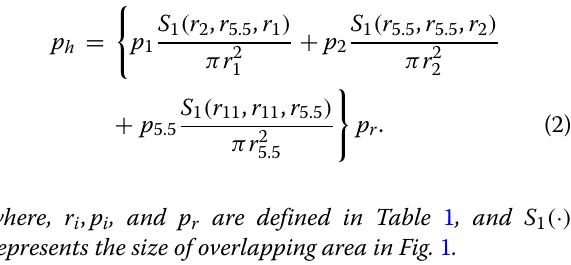
where U inc = U max